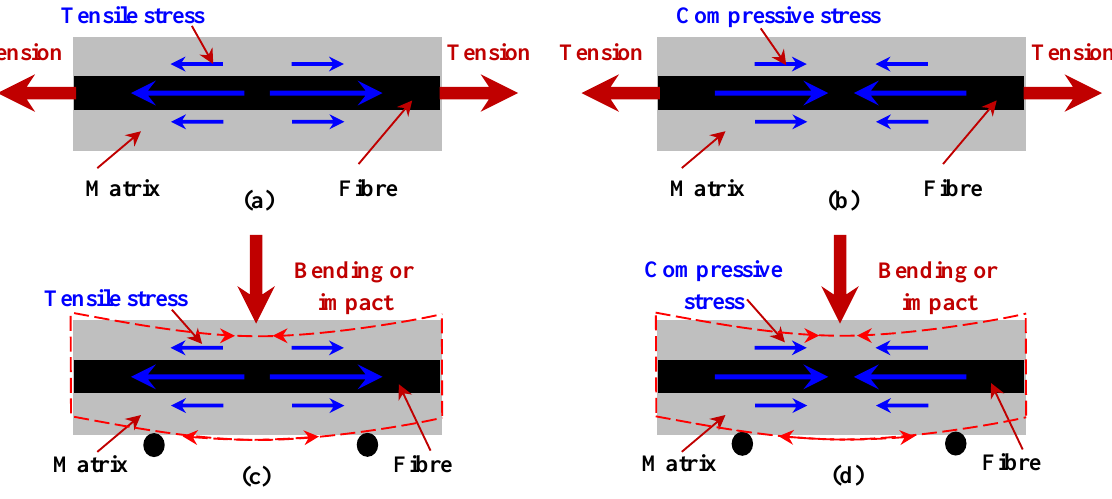
Figure 11. The stress interaction mechanisms within a composite under loading, showing ( a ) as-manufactured composite under tension; ( b ) prestressed composite under tension; ( c ) as-manufactured composite under bending or impact; and ( d ) prestressed composite under bending or impact.